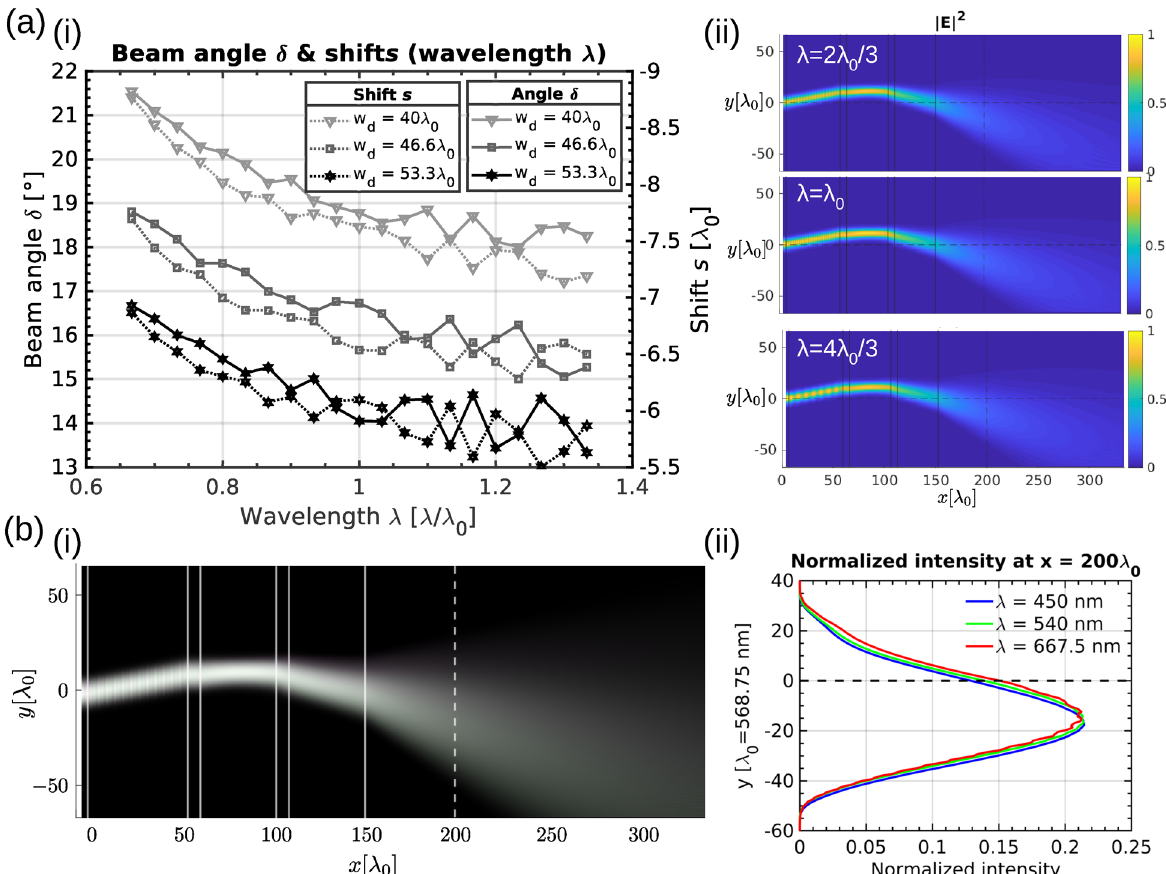
Figure 6. Colour tuning in 3 layer stacked device. ( a ) Wavelength dependence of the beam control with a three- building block device. (i) There is a slight change of shift and deflection angle produced by the deflector building block when the wavelength of the light is changed. (ii) By optimizing the device parameters for a central wavelength of the input spectrum, the effects can be minimized and could be further improved by selecting a LC with appropriate dispersion properties. ( b ) The propagation of white light emitted by an RGB light source into the beam control device. Note good beam colour control. Logarithmic values of RGB intensities are used to plot panel (i). There is good alignment of the intensity peaks of three different wavelengths further away from the lens (at the position, marked by dashed line) as shown in